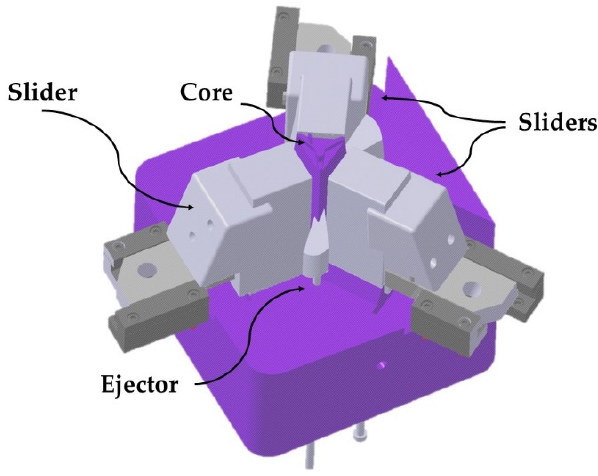
Figure 2. Side sliders. Figure 2. Side